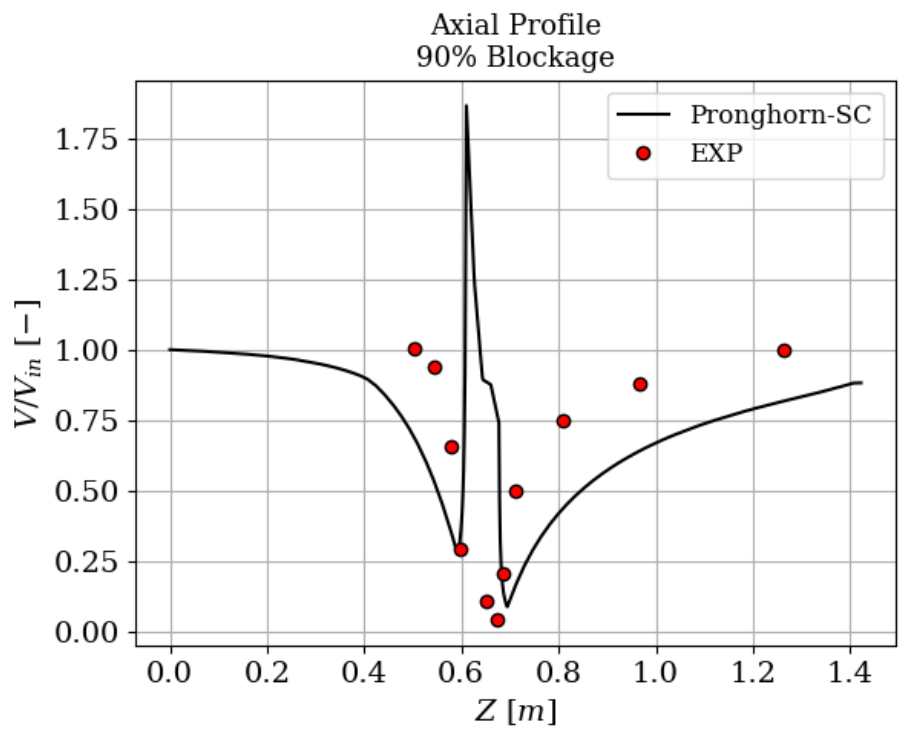
Figure 12. The 90% sleeve